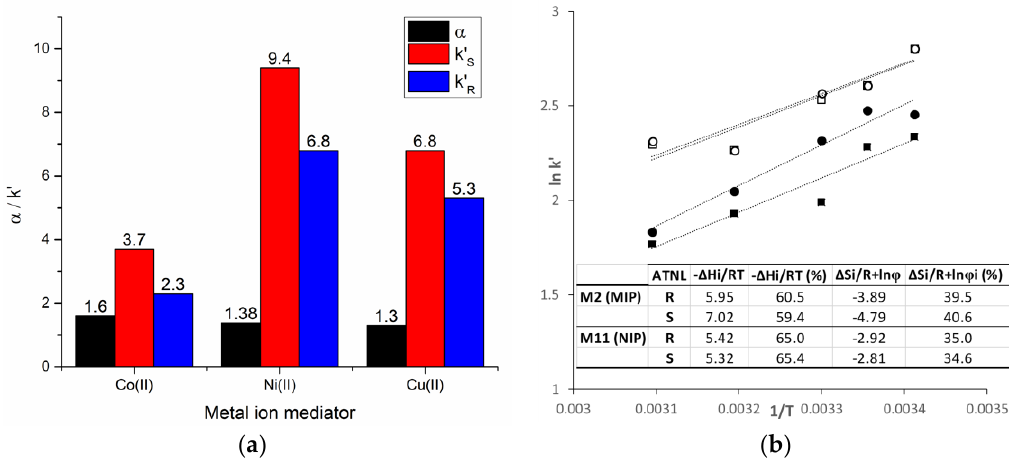
Figure 4. ( a ) Enantioselectivity (α) and chromatographic retention (k’ S /k’ R ) of metal ion-mediated imprinted monoliths (M2—Co(II), M3—Ni(II), M4—Cu(II)). ( b ) Thermodynamic retention study of ATNL’s enantiomers on metal ion-mediated molecularly imprinted (M2, ● — S-ATNL, ■ — R-ATNL) and non-imprinted (M8, ◯ — S-ATNL, ☐ — R-ATNL) polymers.